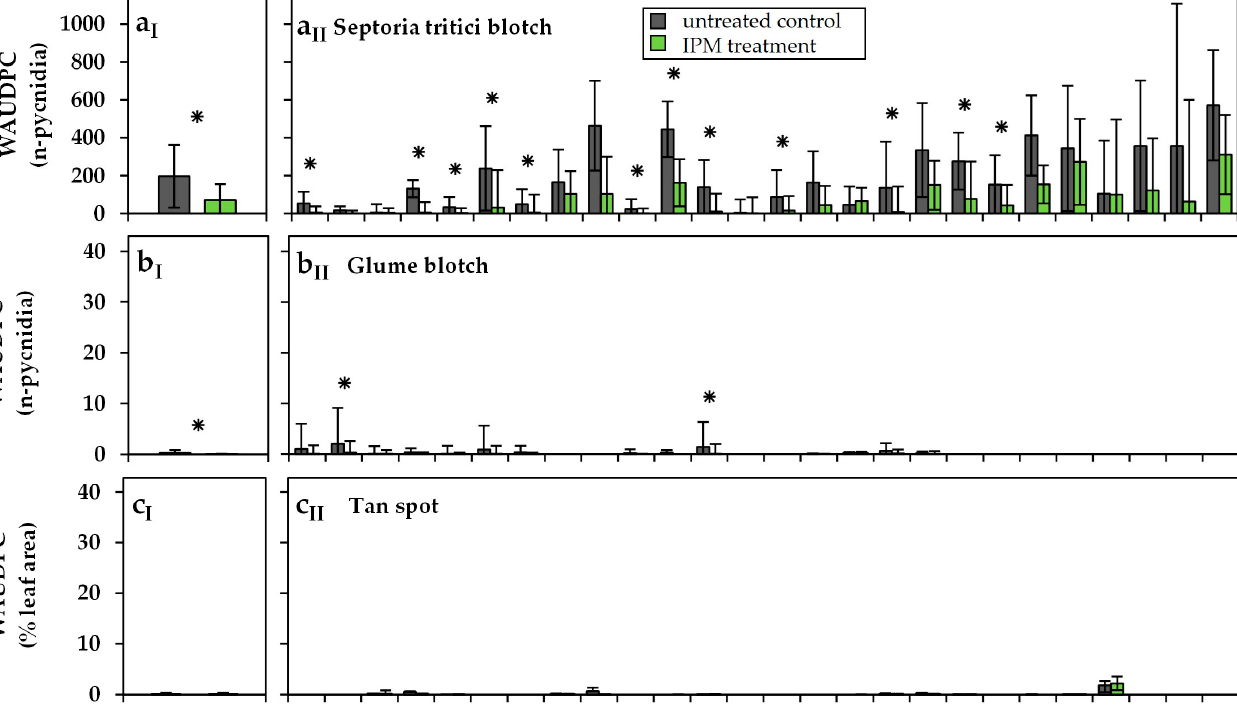
Figure 2. Total ( a I – f I ) and annual ( a II – f II ) weighted disease severities (WAUDPC; F-0 70%; F-1 20%; F-2 10%; F-3 to F-6 0%) of ( a ) Septoria tritici blotch (number of pycnidia), ( b ) glume blotch (number of pycnidia), ( c ) tan spot (percentage of leaf area affected), ( d ) powdery mildew (percentage of leaf area affected), ( e ) stripe rust (percentage of leaf area affected), and ( f ) leaf rust (percentage of leaf area affected) of the untreated control (black bars) and IPM treatment (green bars) of winter wheat (cultivar “Ritmo”) of the eight trial locations in northern Germany from 1995 to 2021. Significant ( p ≤ 0.05) differences treatment differences are marked with *.